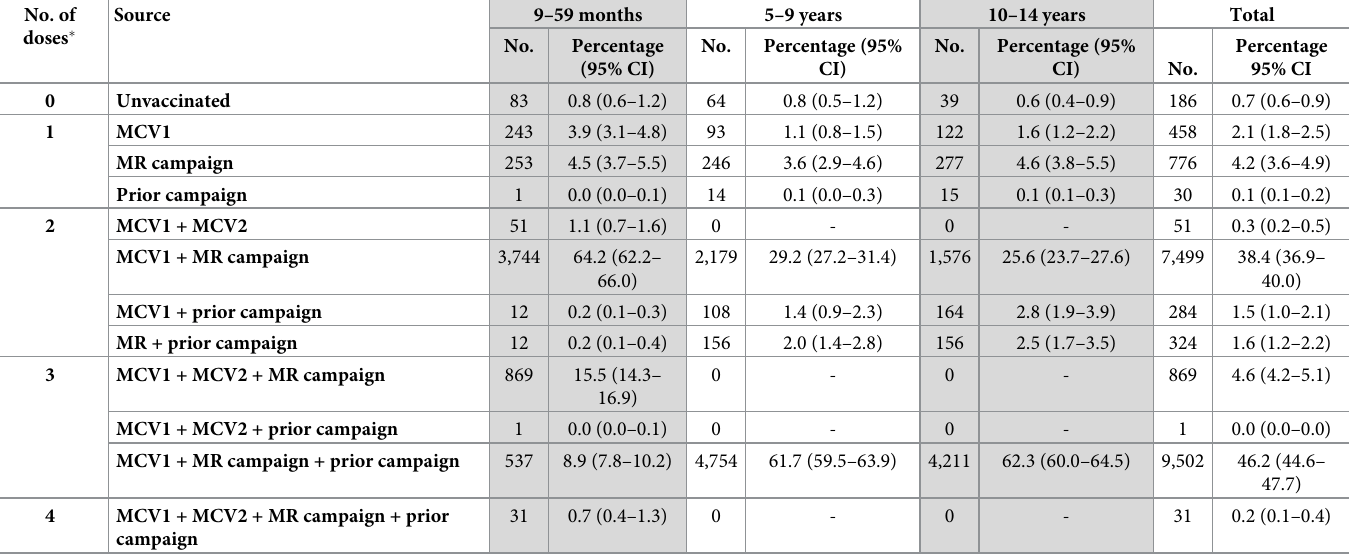
Table 4. Estimated proportion of children by age group and number of measles doses received at the end of the measles-rubella vaccination campaign—Kenya, 2016. No. of doses (cid:3)